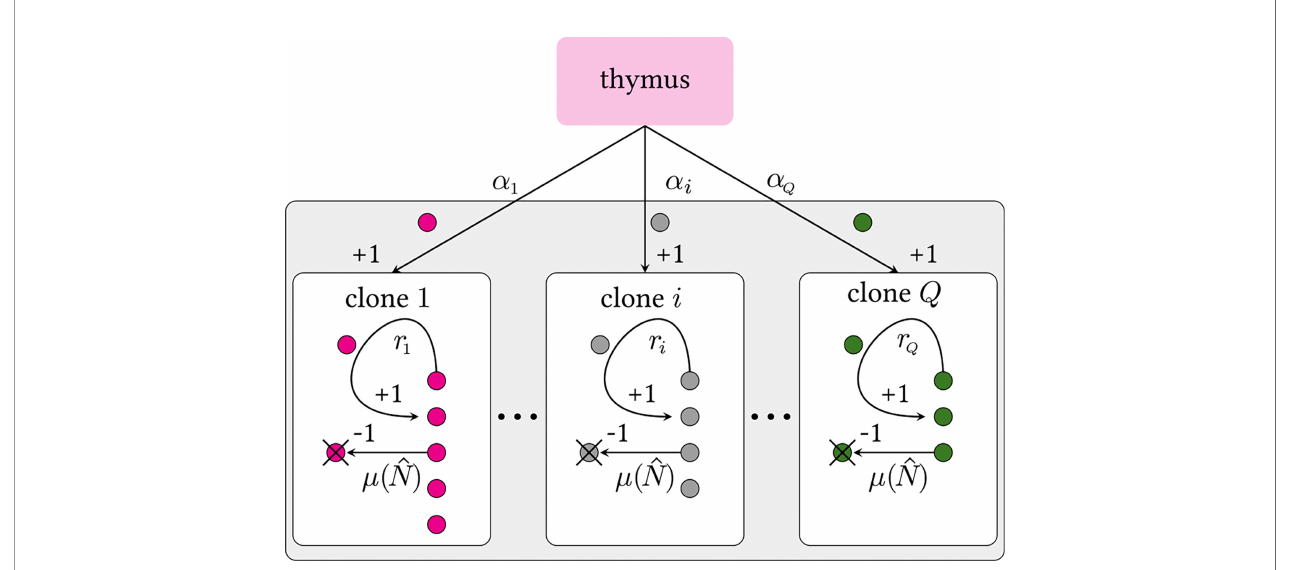
FIGURE 2 | Schematic of a multiclone birth-death-immigration process. Clones are de fi ned by distinct TCR sequences i . Each clone carries its own thymic output and peripheral proliferation rates, a i and r i , respectively. We assume all clones have the same population-dependent death rate m ( N ̂ ), where N ̂ is the total number of cells in the organism that in fl uence the death rate. Since Q ≫ 1, we impose a continuous distribution over the rates a and r . Theoretically, there may be Q ≳ 10 15 (6) or more (30, 31) possible viable V(D)J recombinations. The actual, effective number of different selected TCRs sequences is expected to be much less since extremely low probability sequences may never be formed during the organism ’ s lifetime. A strict lower bound on Q is the actual number of distinct clones C ̂ in an entire organism [ C ̂ ∼ 10 6 – 10 8 for humans (1, 6, 32 –